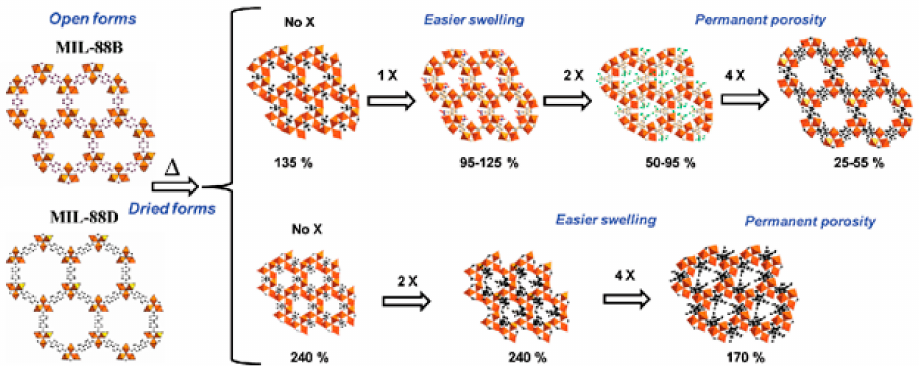
Figure 6. Illustration for swelling phenomena of the structure and the flexibility of the MIL-88B and MIL-88D modified solids as a function of the number of functional groups (X) per spacer (on the top)